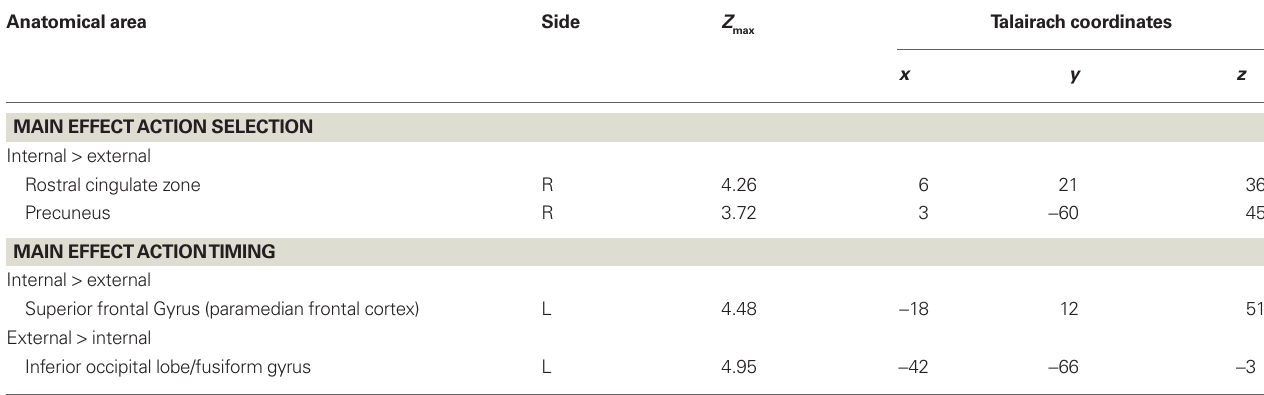
Table 1 | Anatomical location, hemisphere, maximum Z value ( p = 0.001, corrected) and Talairach coordinates. Cue-related activations with a minimum cluster size of 1134 mm 3 are